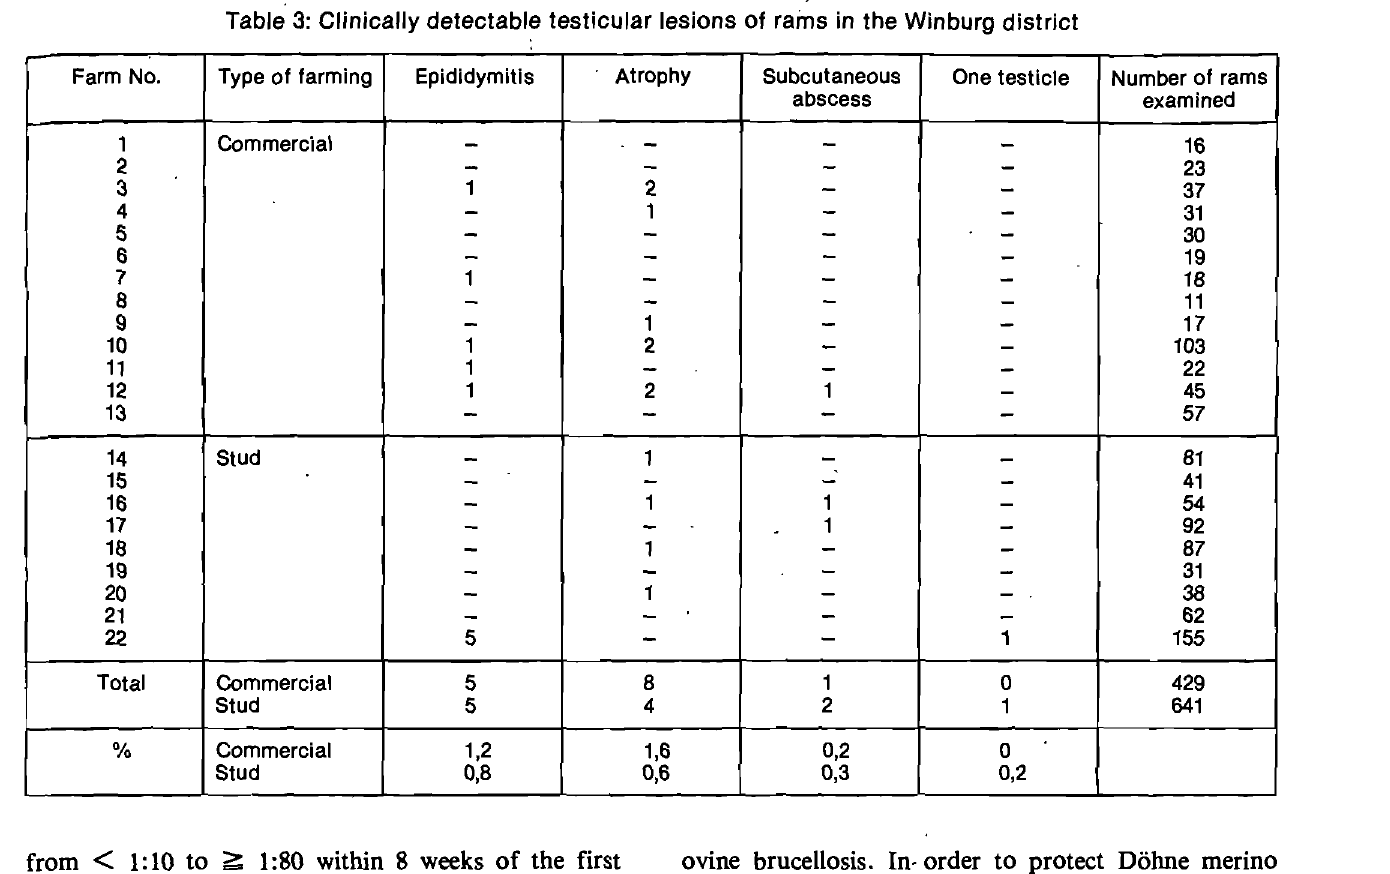
Table 3: Clinically detectable testicular lesions of rains in the Winburg district Farm